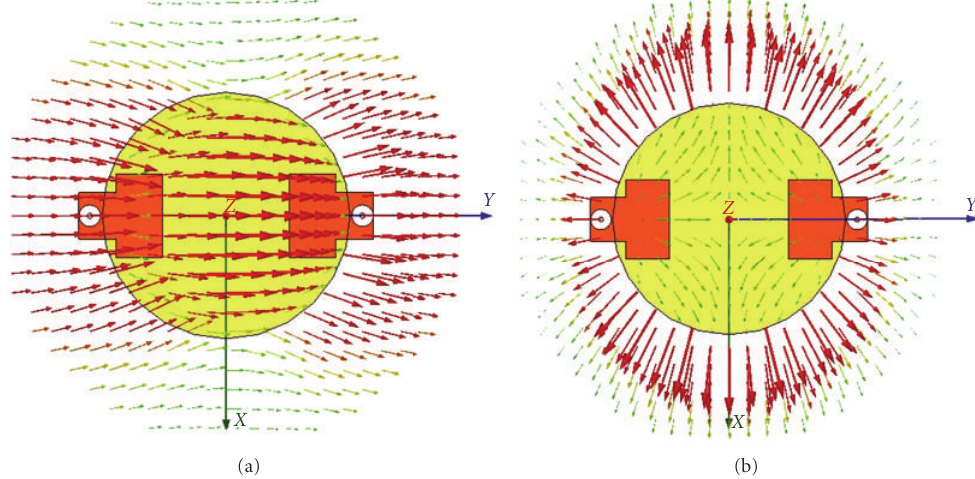
Figure 3: (a): Electric field distribution when the power is applied to the sum port and (b): the power is applied to the di ff erence port. The two T-shaped patches are connected to the bottom microstrip network by